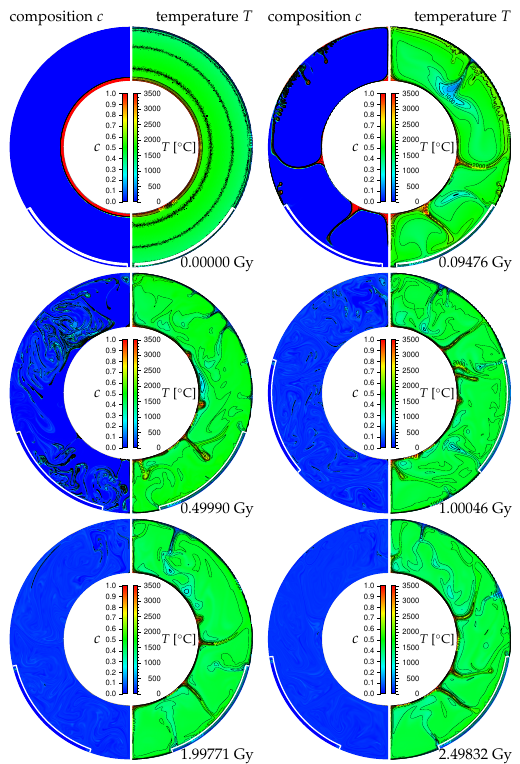
Figure 4. Snapshots of the thermochemical states of Case 2 at the elapsed times indicated in the figure. Shown by color and contour lines in each row are the distributions of fraction c of the dense component (left) and temperature T (right). For the color scale for the distributions of c and T , see the scale bars in the figure. In each figure, the thick white lines indicate the positions of the continental lid at the top surface. Note that the mirror symmetry at the side walls ( θ = θ min and θ max ) is assumed in displaying the distributions of c and T : in each snapshot θ = θ max is located at its top, while θ = θ min is at its bottom, and θ increases from θ min to θ max in clockwise and counterclockwise directions in the snapshots of composition c and temperature T , respectively.